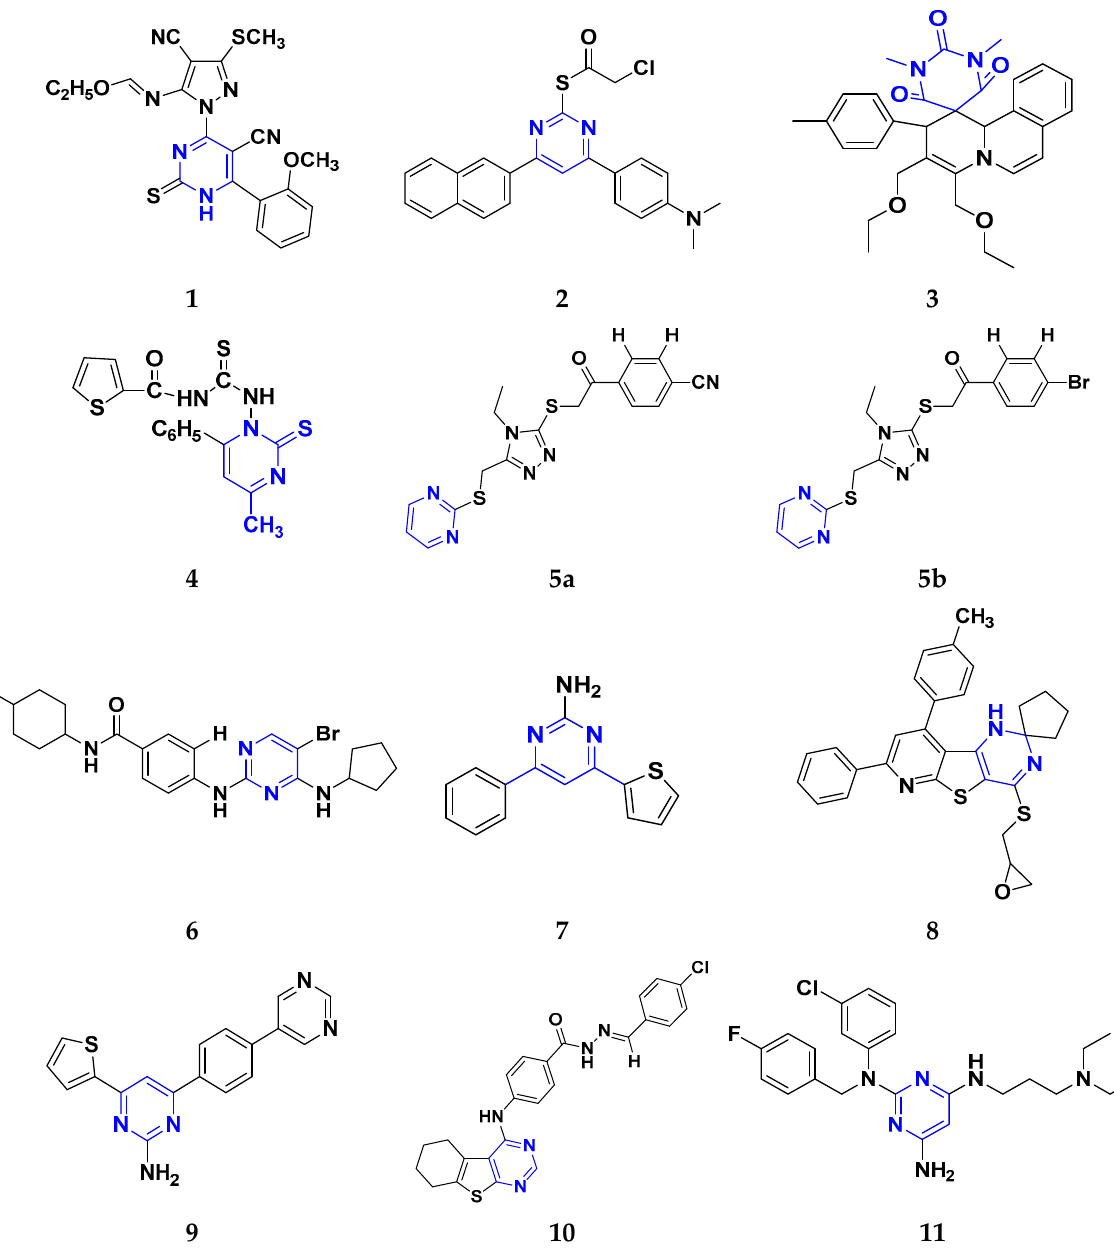
Figure 3. Pyrimidine derivatives ( 1 – 11 ) as anticancer agents.